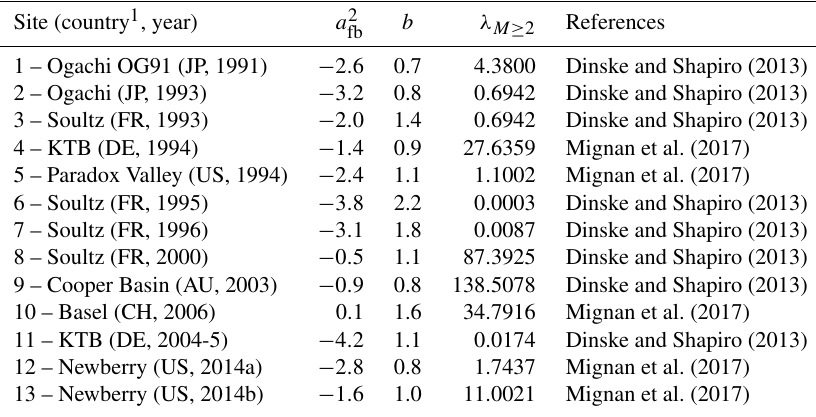
Table 1. Underground seismic feedback to deep fluid injection.